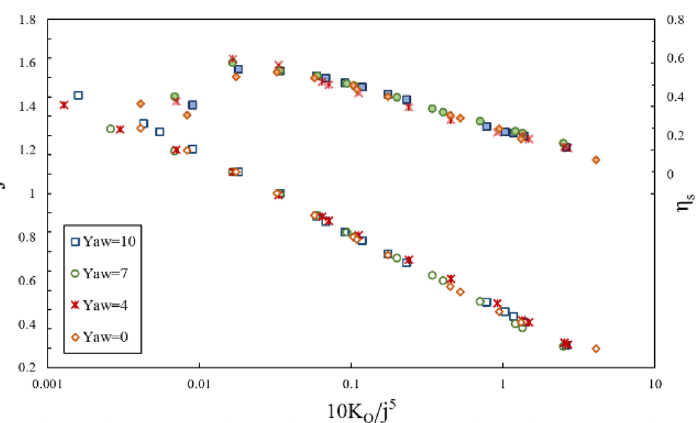
Figure 29. The effect of yaw angle on torque coefficient and efficiency in the propulsion direction ( I = 0.6 ).